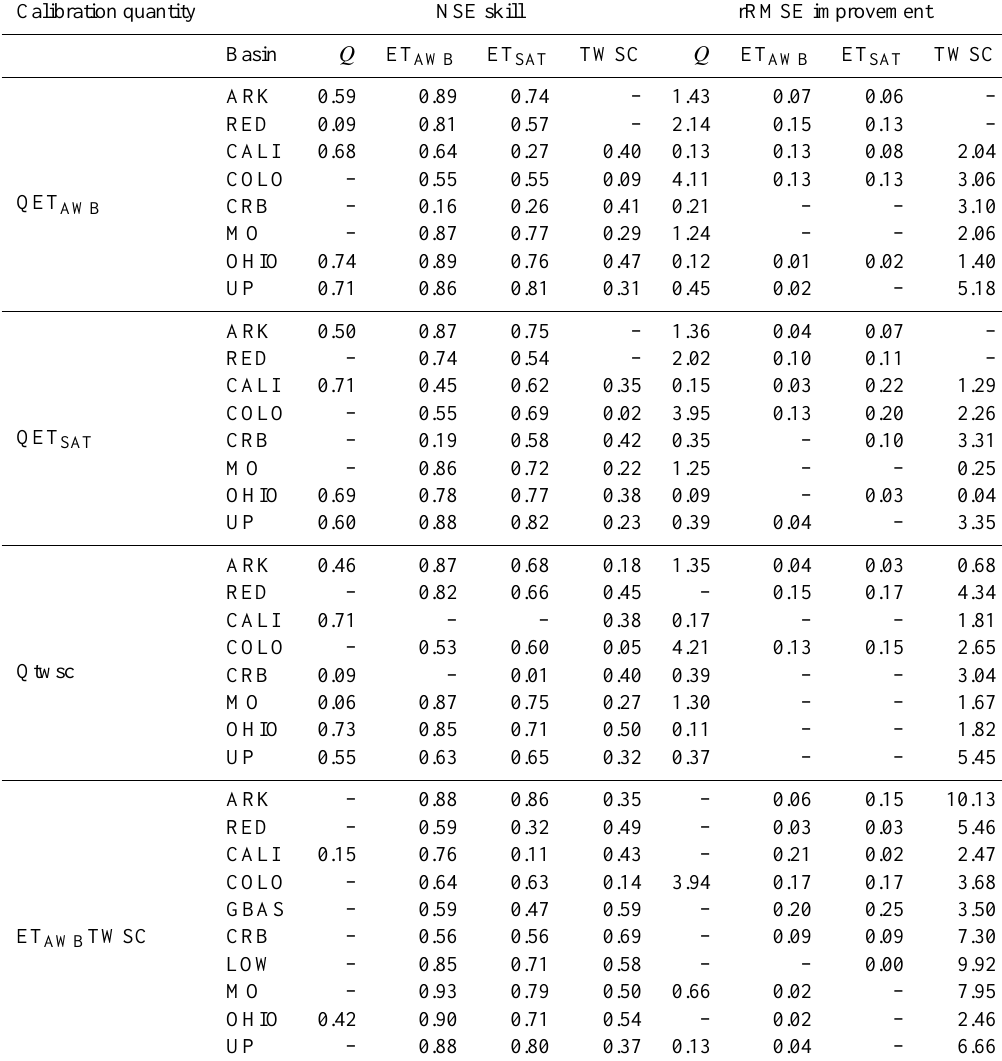
Table 4. Same as Table 3, except for multi-criteria calibrations. Calibration